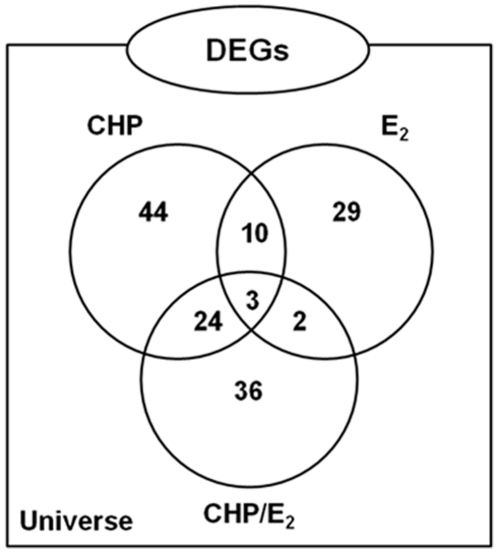
Venn diagram representation of gene expression patterns.The diagram clearly depicted that only two of the five overlapping genes
were specifically shared between E2 and CHP/E2:
AJ625117 with no annotation, and AJ516728, a putative dermatopontin.
Data used to generate the Venn-diagram were obtained from microarray
analysis (Table S1).